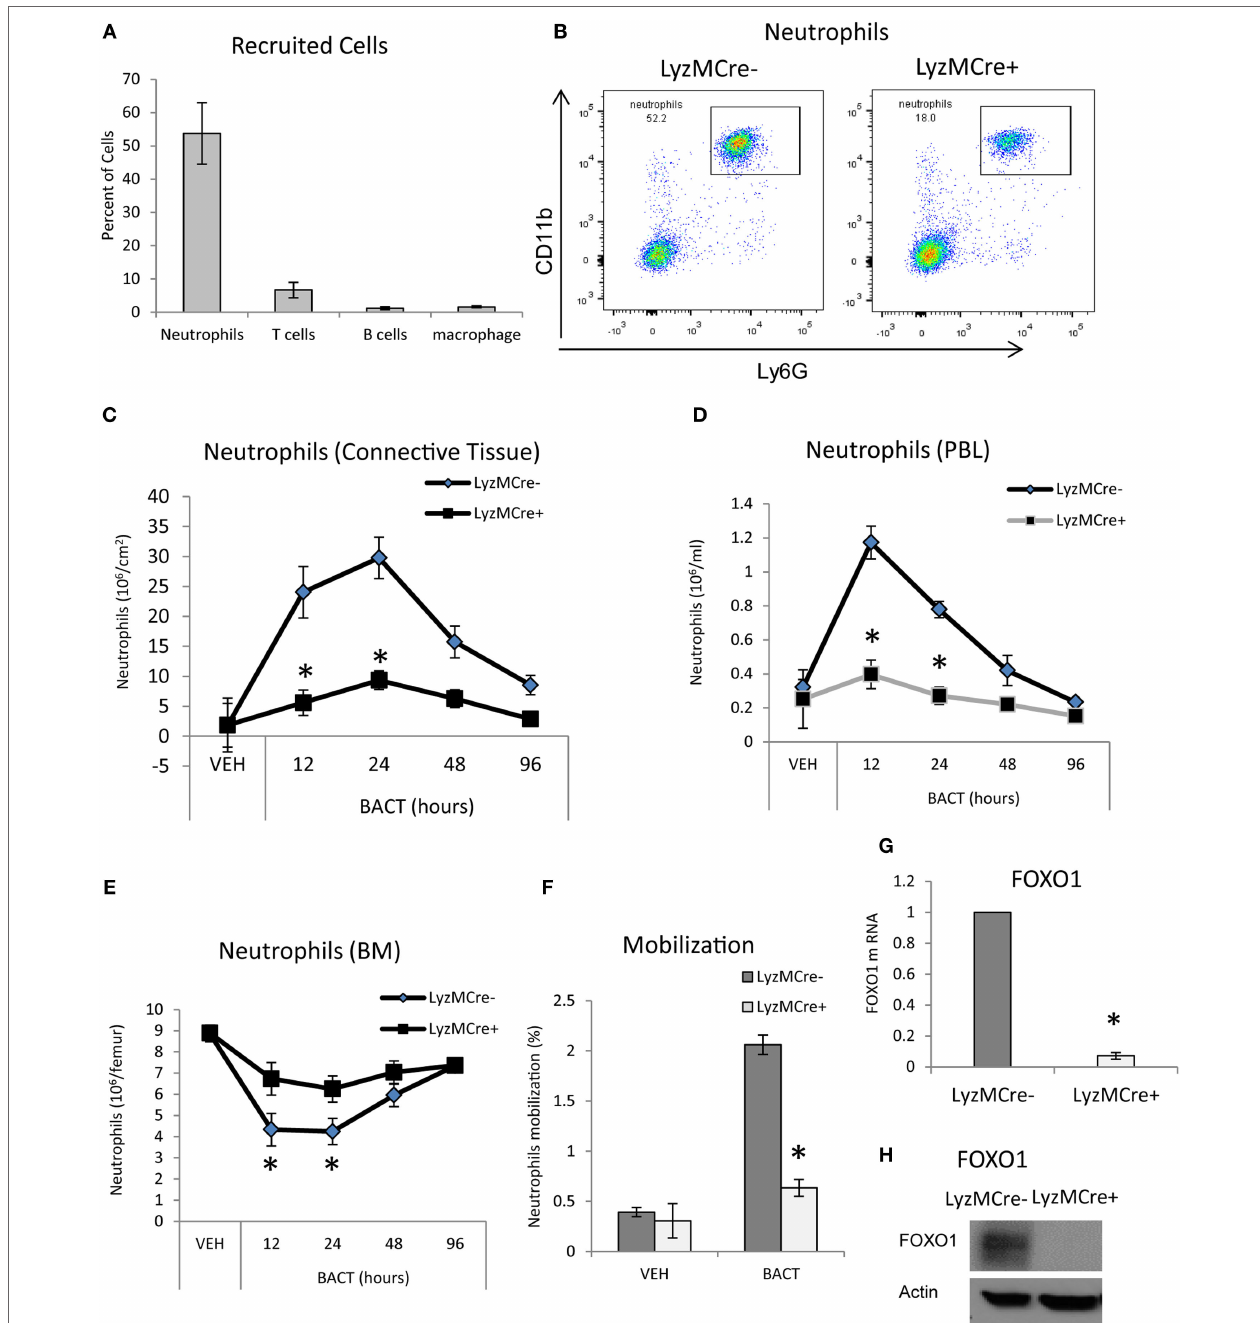
FigUre 1 | FOXO1 deletion impairs bacteria-induced neutrophil recruitment. (a,B) Porphyromonas gingivalis was inoculated into the connective tissue of the scalp and mice were examined at the indicated time points. (a) The mice was euthanized at 12 h and number of cells in the inoculated tissue and (B) neutrophils in peripheral blood were measured by immunofluorescent flow cytometry using specific antibodies for neutrophils (Ly6G), T cells (CD3), B cells (B220), and macrophages (F4/80). FOXO1-deleted LyzM.Cre + FOXO1 L/L mice and littermate control LyzM.Cre − FOXO1 L/L mice were inoculated with bacteria at the indicated time points. The number of neutrophils in the inoculated tissue (c) , peripheral blood (D) , and bone marrow (e) was measured by immunofluorescent flow cytometry using specific antibodies. (F) Neutrophil mobilization was calculated as described in methods to estimate the percentage of total neutrophils in the blood. RNA was isolated from mouse neutrophils from FOXO1-deleted LyzM.Cre + FOXO1 L/L mice and littermate control LyzM.Cre − FOXO1 L/L mice. FOXO1 mRNA levels were measured by RT-PCR and normalized to ribosomal protein L32 (g) . (h) Neutrophils from experimental LyzM.Cre + FOXO1 L/L mice and littermate control LyzM. Cre − FOXO1 L/L mice were analyzed by Western blots for FOXO1 expression with actin as loading control. The data are representative of two or three independent experiments. Data are presented as the mean ± SEM from triplicate samples. *Significant difference between neutrophils from FOXO1-deleted LyzM.Cre + FOXO1 L/L mice and littermate control LyzM.Cre − FOXO1 L/L mice ( P < 0.05).